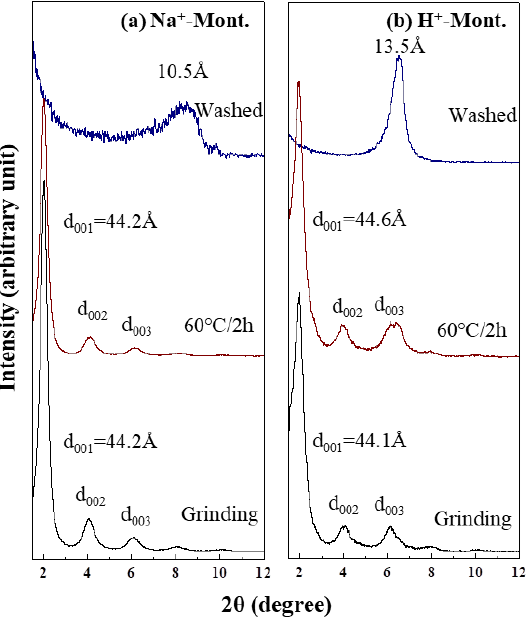
Figure 3. XRD patterns of CDEA–montmorillonite composites as a function of the interlayer cations ( a ) Na + and ( b ) H + after grinding and washing.